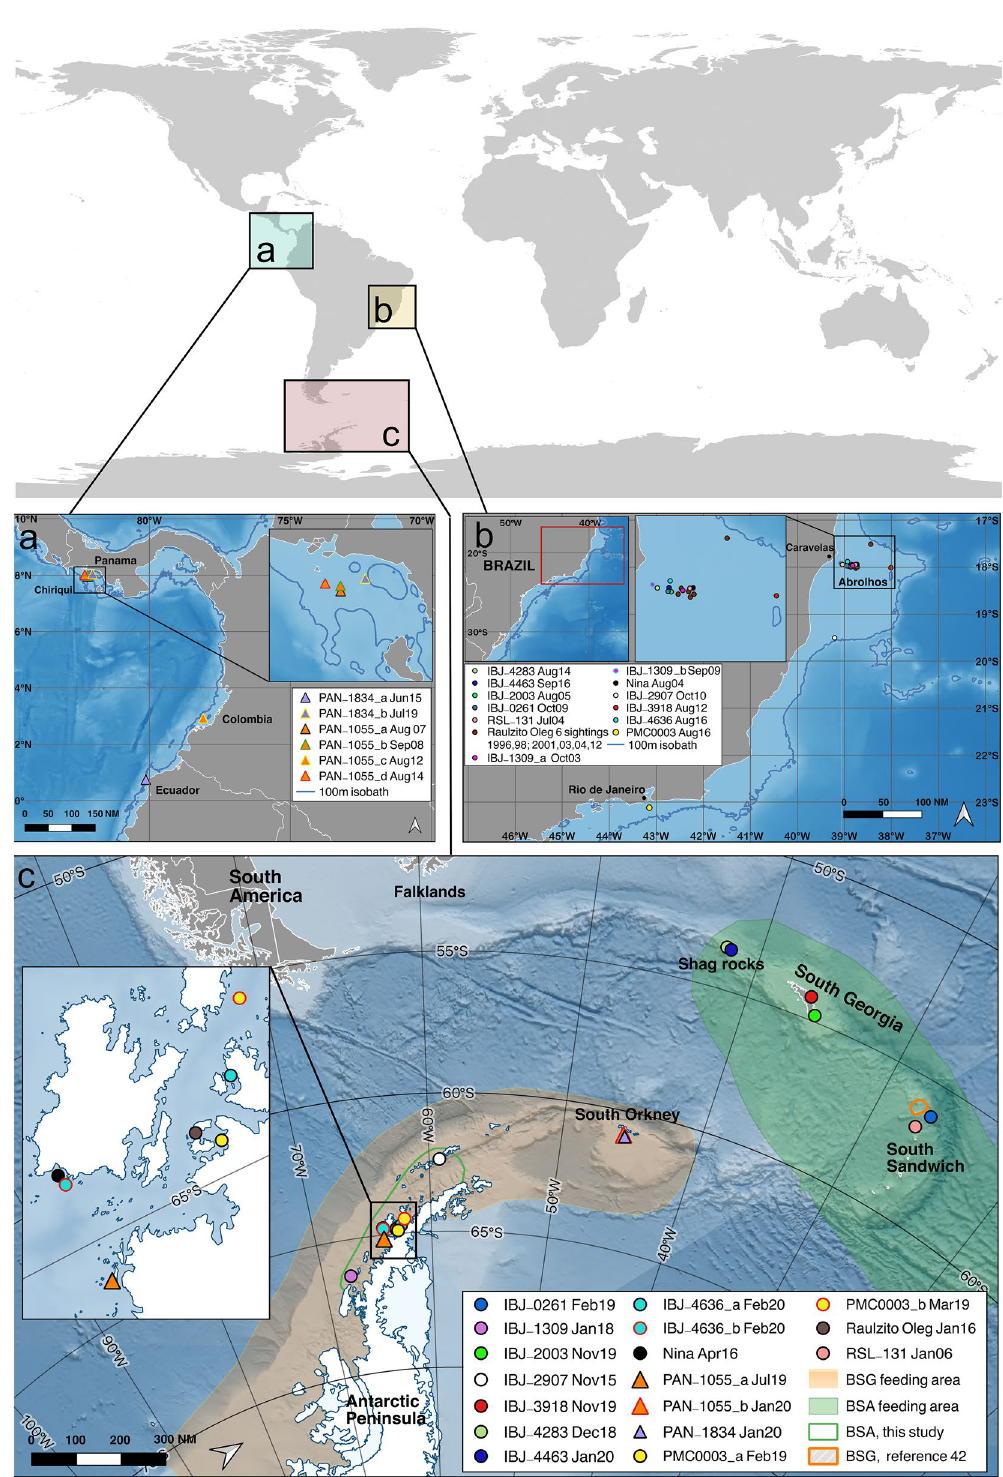
Figure 1. Maps of the breeding areas of breeding stock ‘G’ (BSG in a ) and breeding stock ‘A’ (BSA in b ), and feeding areas off the Antarctic continent ( c ). Putative feeding grounds for BSA are shown on the bottom map ( c ) in a shade of green 25–29 and for BSG in a shade of orange 24 . Colored symbols (circle for whales from BSA and triangles for whales from BSG) indicate where individuals were photo-identified. The green line within the BSG putative feeding area delimits where BSA whales are feeding in the WAP (this study) and the orange line indicates previous information of a BSG whale feeding on the putative BSA feeding area 42 . Maps were created using QGIS version 3.16 (2021, Open Source Geospatial Foundation Project, http:// qgis. osgeo. org) and Inkscape version 0.92.5 (2020, Inkscape Project, https:// inksc ape.